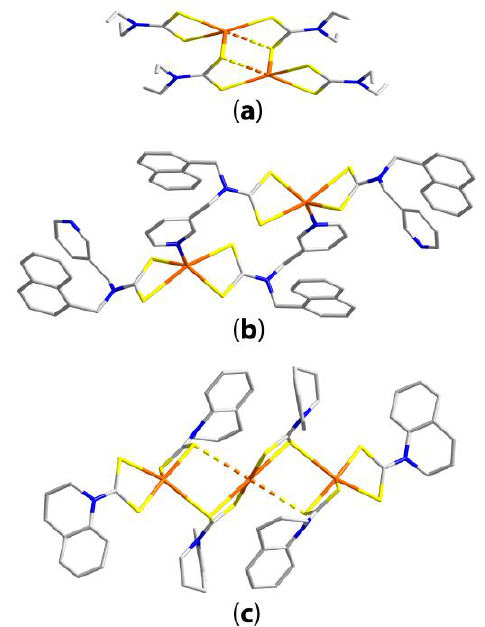
Figure 15. Molecular structures of ( a ) binuclear [Hg(S 2 CNEt 2 ) 2 ] 2 ( 163 ); ( b ) binuclear [Hg{S 2 CN[CH 2 (3- py)]CH 2 (1-naphthyl)} 2 ] 2 ( 179 ); and ( c ) trinuclear [Hg(S 2 CNR 2 ) 2 ] 3 ( 180 ), where NR 2 is 1,2,3,4- tetrahydroquinoline. The dashed Hg … S bonds represent weak interactions.